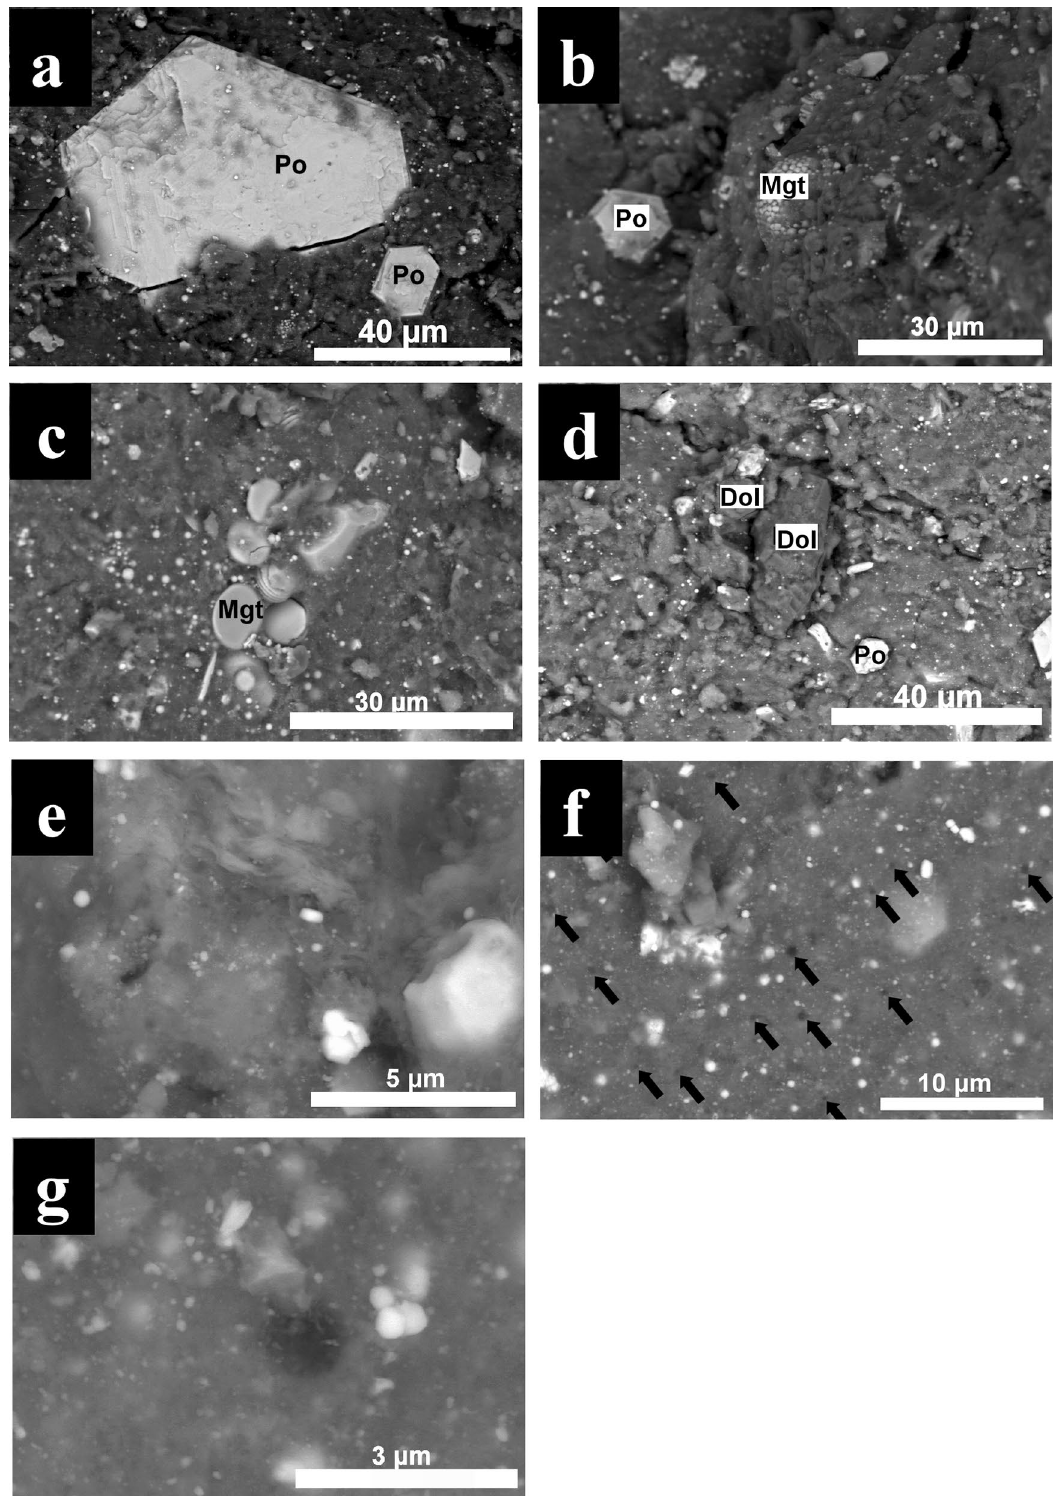
Fig. 4 Back‑scattered electron images of major constituent phases in A0042, dark group. a Euhedral hexagonal morphology of pyrrhotite showing a smooth texture. b Framboidal magnetite. c Plaquette magnetite. d Ca–Mg carbonate, dolomite. e ) Coarse‑grained phyllosilicate. f Circular structure‑enriched region. Larger ones are indicated by arrows. g High‑resolution image of a circular